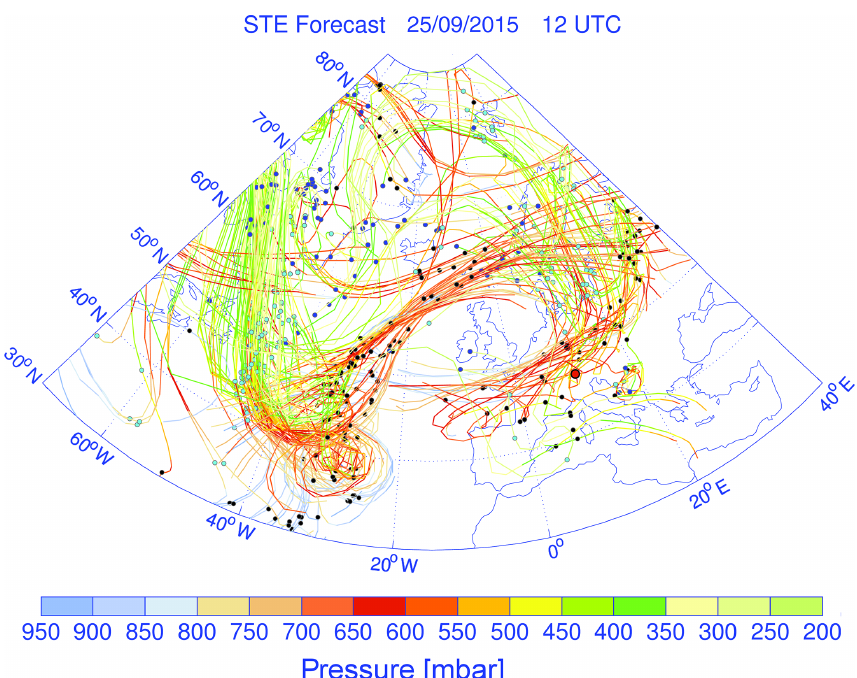
Figure 3. Recalculation of the LAGRANTO forward trajectories based on ERA-Interim wind data: the length of the trajectories is 5d. Less than 1% of the trajectories are displayed for clearness. The pressure level is colour coded in mbar. The start time t 0 is 25 September 2017, 12:00UTC (13:00CET), marked with dark blue dots. The times t 0 + 2d and t 0 + 4d are marked with bright blue and black dots, respectively. The red dot north of the Italian peninsula marks the position of Garmisch-Partenkirchen.